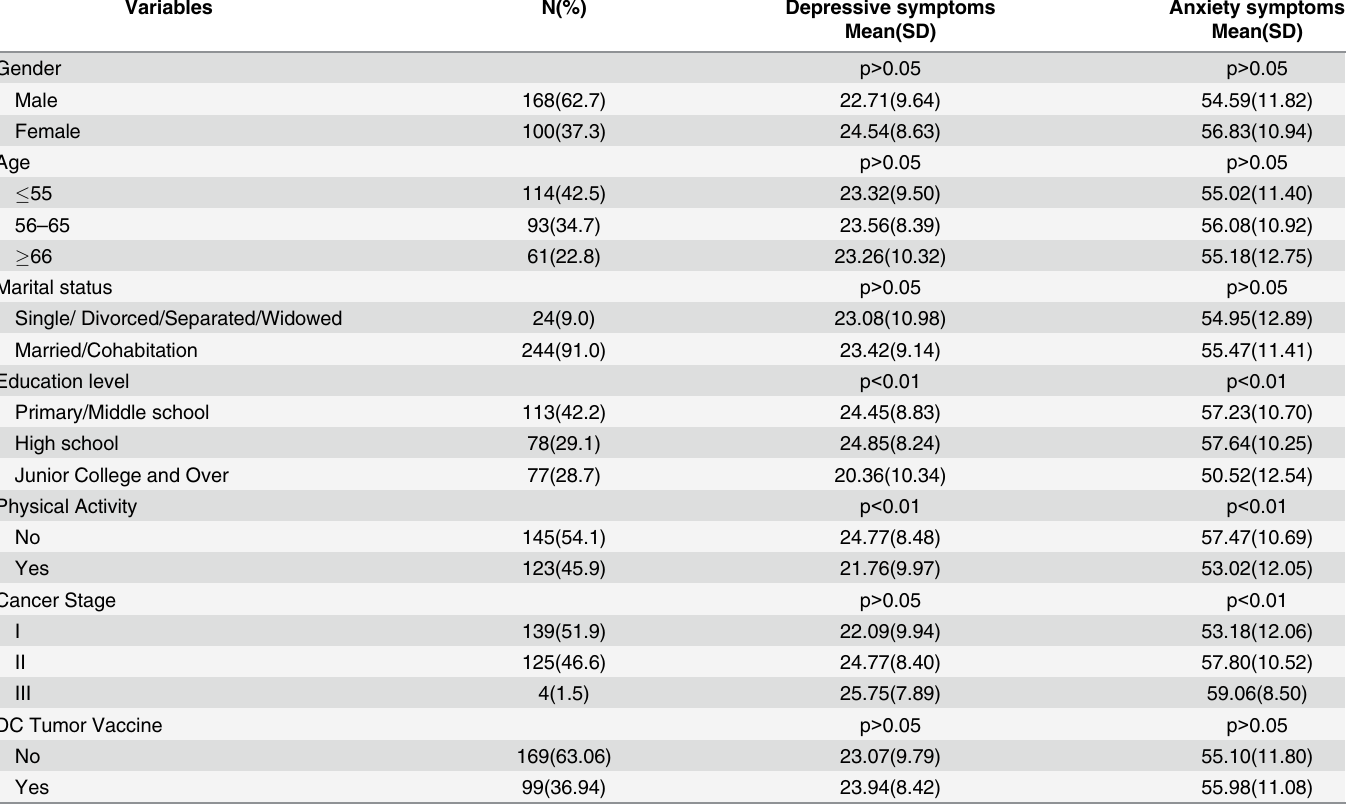
Table 2. Demographic and clinical characteristics of subjects and the distributions of depressive and anxiety symptoms among renal cancer patients. Variables N(%) Depressive symptoms Anxiety symptoms